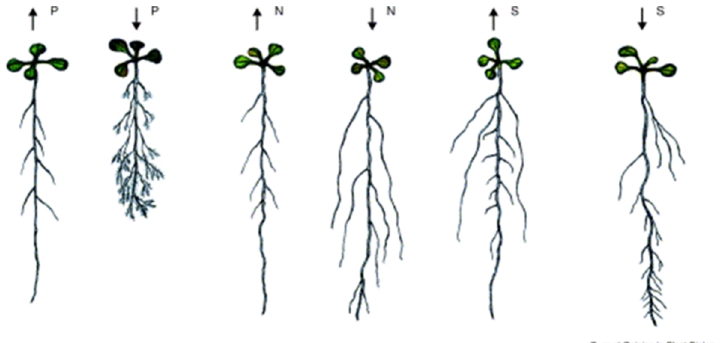
Figure 1. Root development in Arabidopsis based of differing macronutrient content [7]. When Arabidopsis was grown in growth media containing differing concentrations of P (phosphorus), N (nitrogen), and S (sulfur), there were predictable patterns in root structural development. Reduction in nitrogen levels displayed increases in lateral root formation.